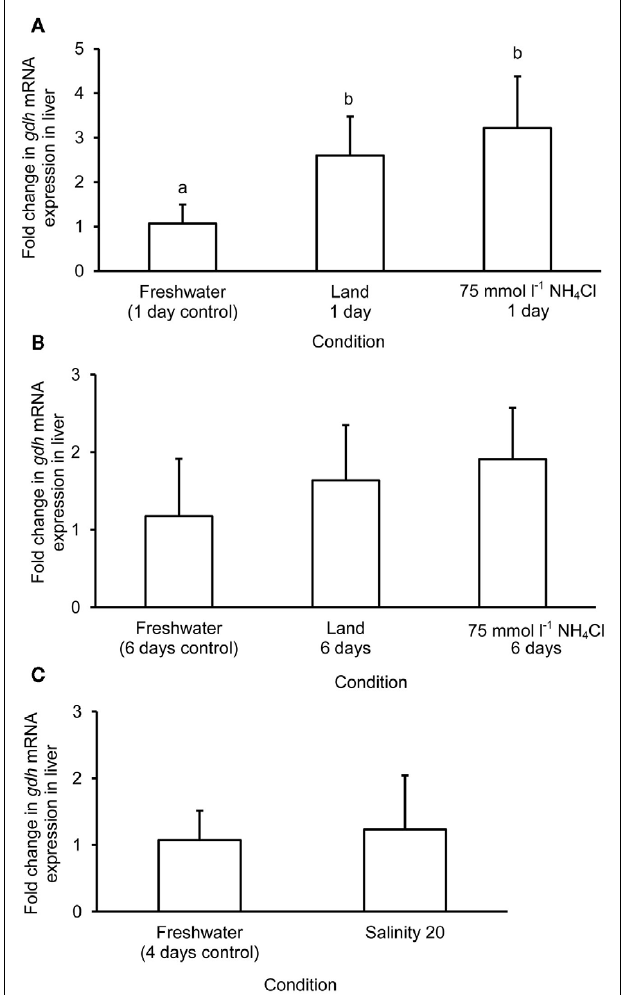
FIGURE 4 | Effects of (A) 1day of exposure to freshwater (control), terrestrial conditions, or 75mmoll − 1 NH 4 Cl, (B) 6days of exposure to freshwater (control), terrestrial conditions (land), or 75mmoll − 1 NH 4 Cl, and (C) 4days of exposure to freshwater (control) or 1day of exposure to salinity 20 after a 3-day progressive increase in salinity from freshwater on the mRNA expression (fold change) of glutamate dehydrogenase 1a ( gdh1a ) in the liver of Monopterus albus . Results represent mean + SD ( N = 4). Statistical analysis was applied after log 2 transformation of the individual fold change values. Means not sharing the same letter are significantly different, p <